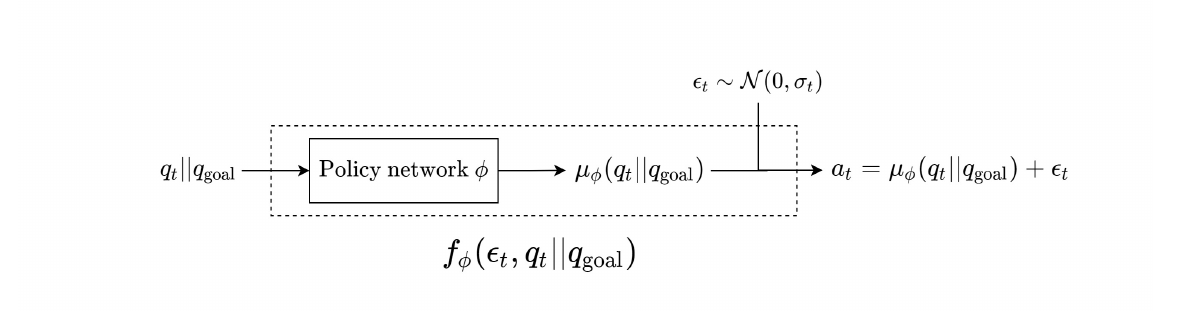
Figure A1. Reparameterized sampler for the continuous action